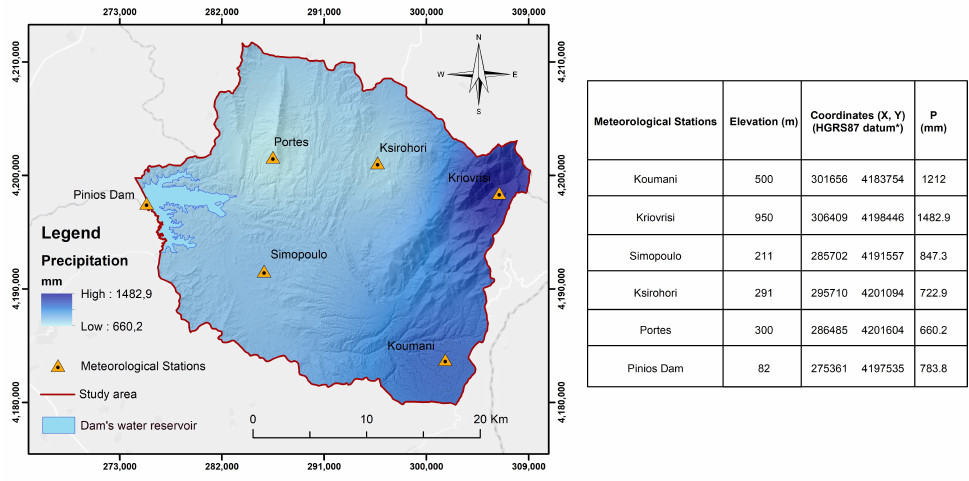
Figure 3. The meteorological stations and the mean annual precipitation map of the research area.